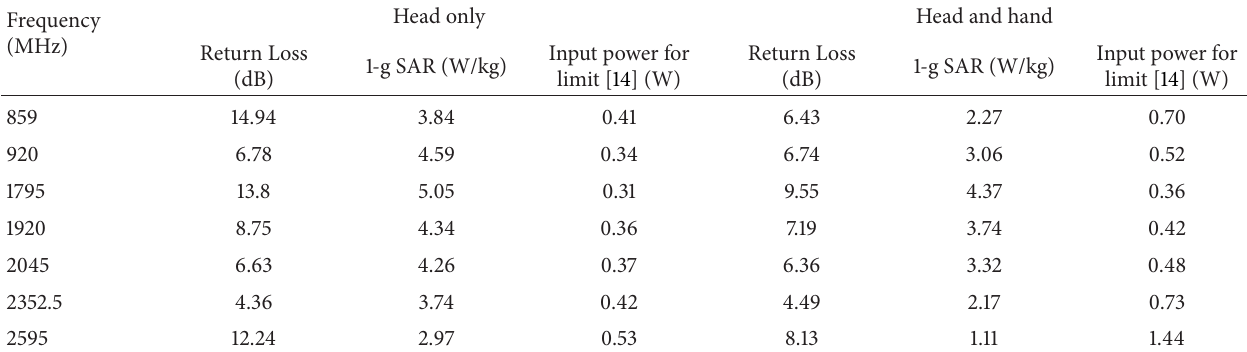
Table 2: Simulated results of the return loss and SAR for the proposed antenna with the head and hand